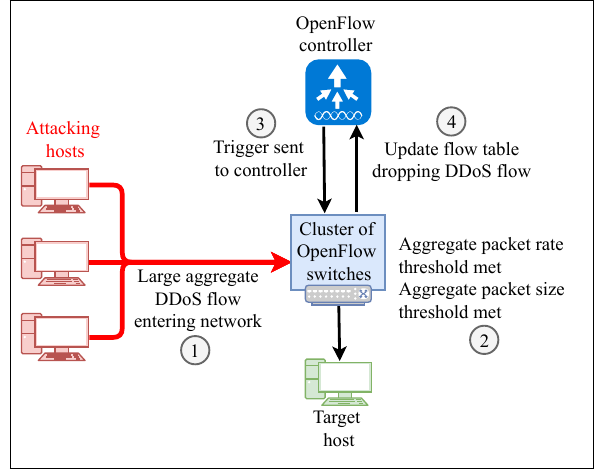
Figure 3. DDoS Attack Mitigation